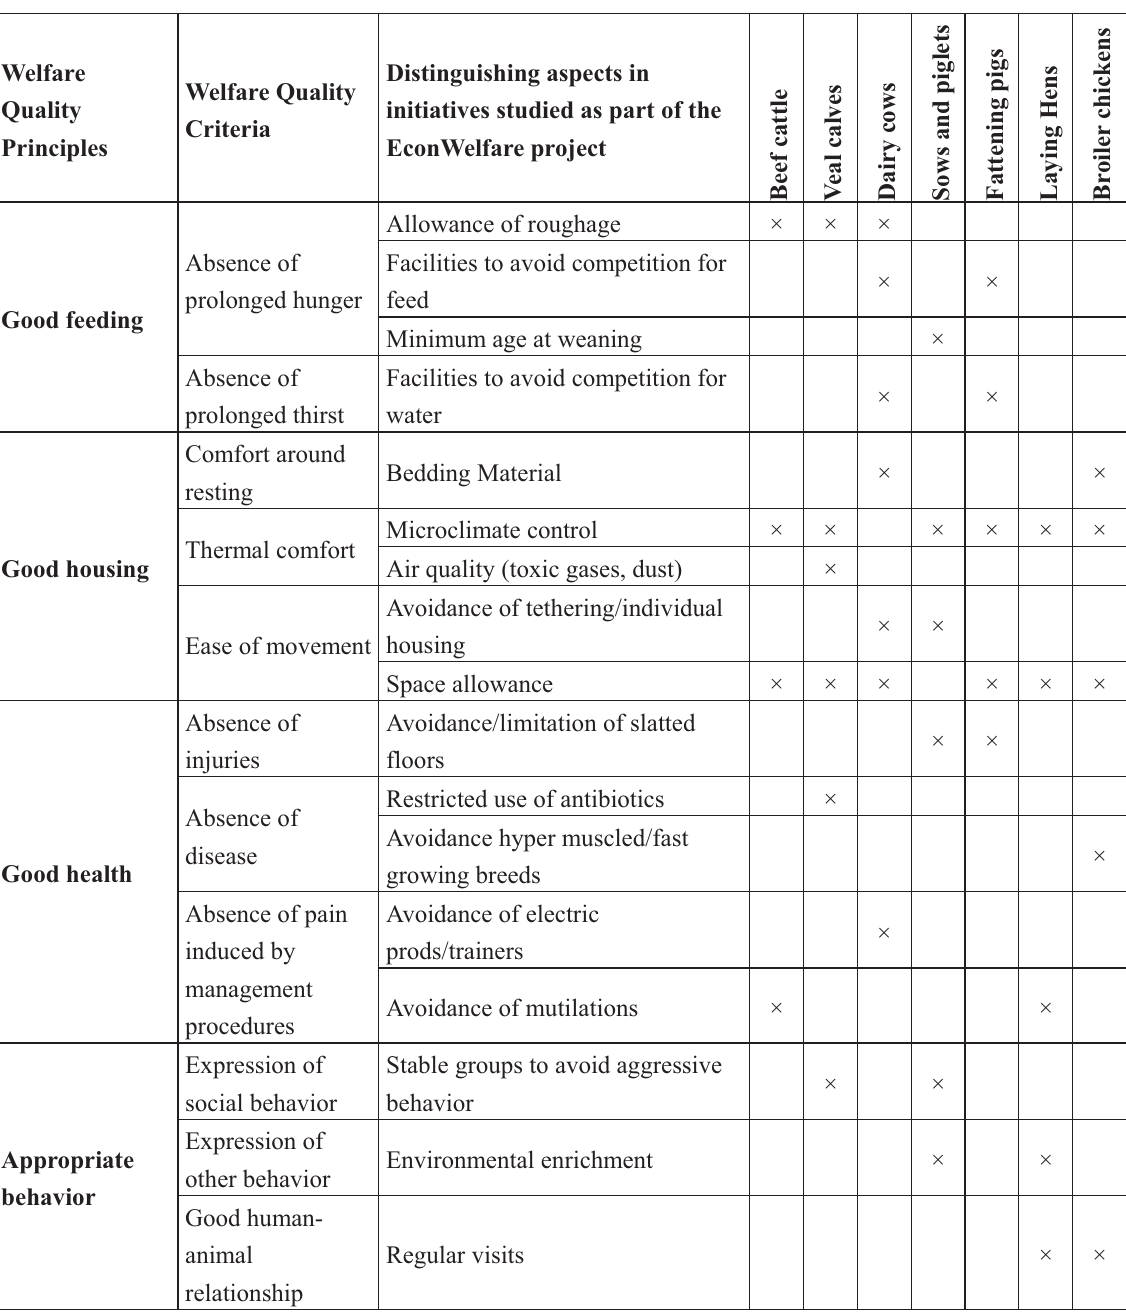
Table 2. On-farm aspects included in the different standards and initiatives that were considered as relevant for animal welfare by the consulted animal welfare scientists (source: